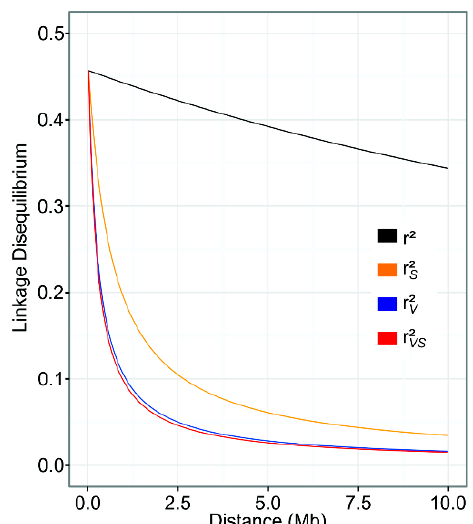
Figure 4. Linkage disequilibrium (LD) decay determined by four LD measurements against distance between SNPs within the chromosome, adjusted by the mutation model.